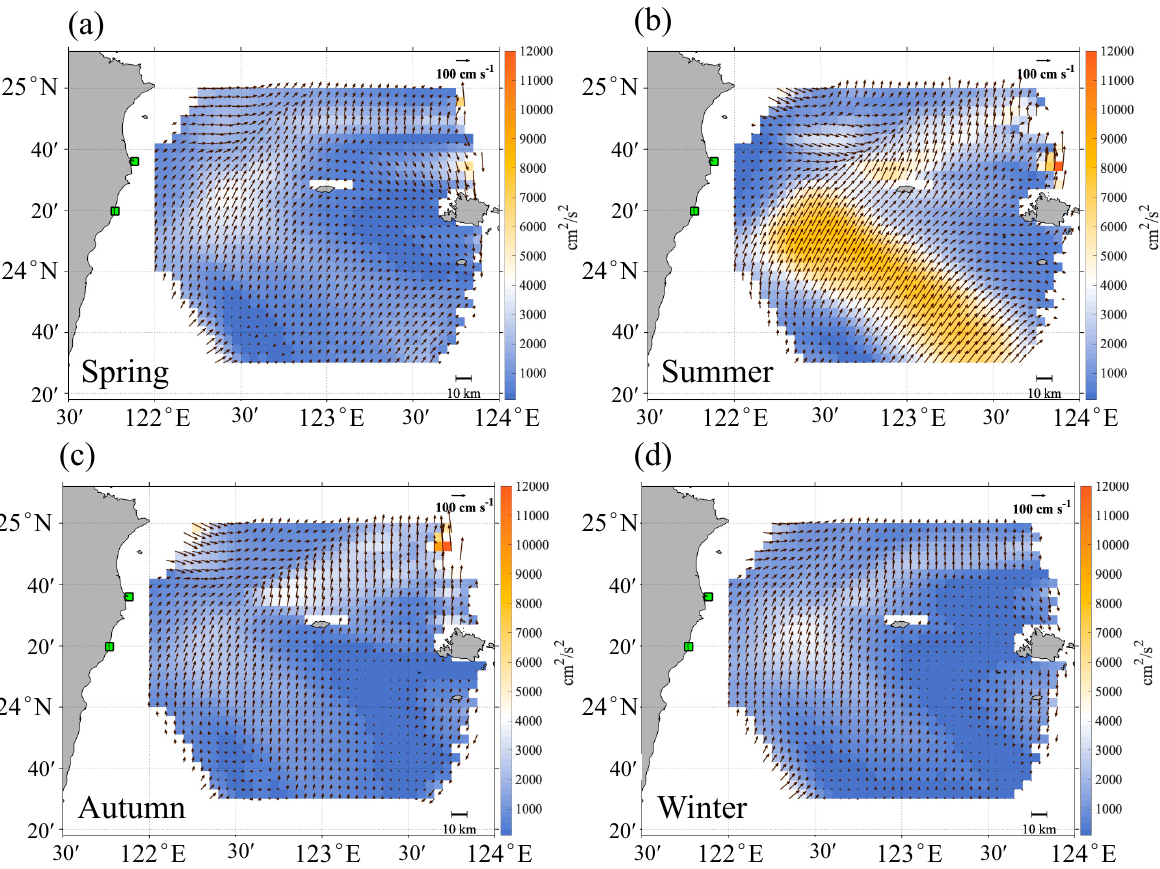
Figure 6. Seasonal current velocities (vectors) in the region off of northeastern Taiwan with the EKE (background color). ( a ) Spring, ( b ) Summer, ( c ) Autumn, and ( d ) Winter .